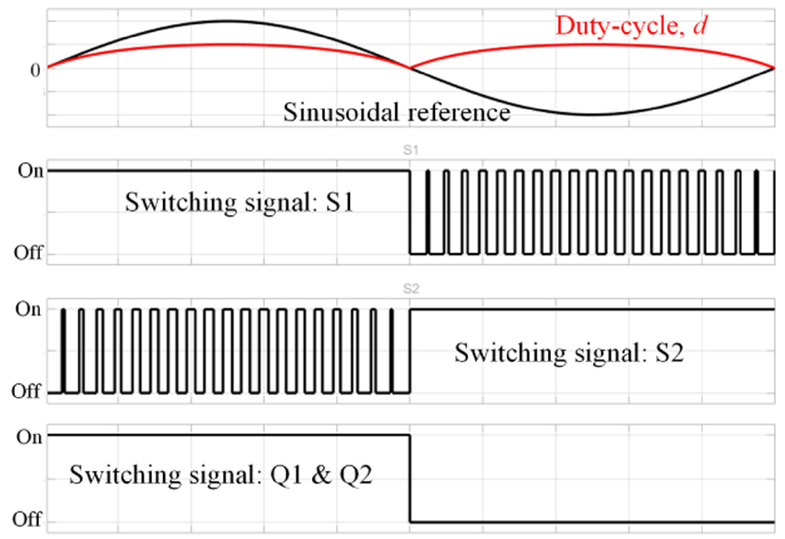
Figure 4. Pulse width modulation scheme of the universal converter operating in mode 3 ( G = 1) for generating a sinusoidal ac voltage.